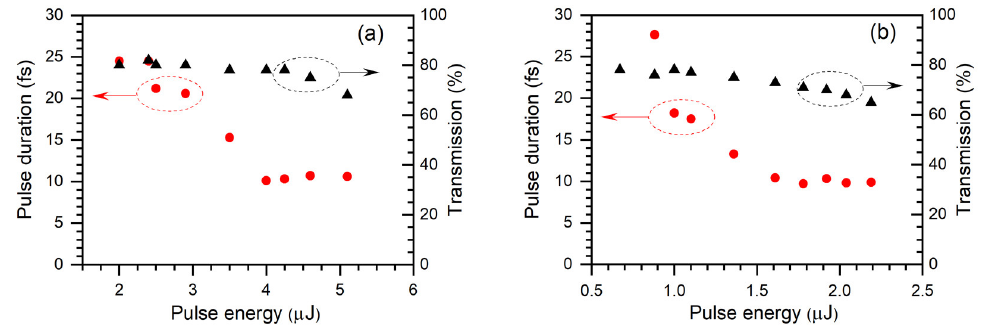
Figure 5. The transform-limited pulse duration (circles) calculated from the experimentally observed spectral width of the pulses as a function of input pulse energy. The fiber transmission (triangles) as a function of the input pulse energy. The size of experimental points corresponds to the error bar of the measurements. The pressure of xenon was 15 atm ( a ) and 40 atm ( b ). The duration of transform-limited pulses decreases with the input pulse energy due to SPM-induced spectral broadening of propagating pulses (Figure 5). Starting at a cer- tain pulse energy, the transform-limited pulse duration reaches a minimal value of about 10 fs and does not change with further energy growth of input pulses. Note, the minimal pulse duration has the same value for both zero dispersion (Figure 5a) and all-normal dispersion (Figure 5b) cases. Such a dependence may indicate that the spectral width of output pulses is limited by some mechanism, which could be the bandwidth of the HCF transmission band (Figure 2a).